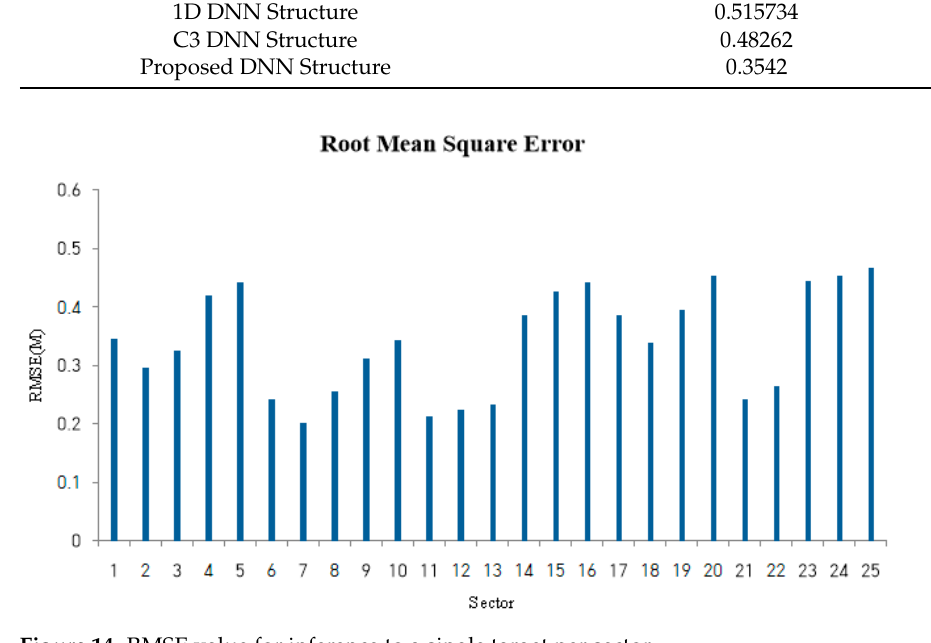
Figure 14. RMSE value for inference to a single target per sector.